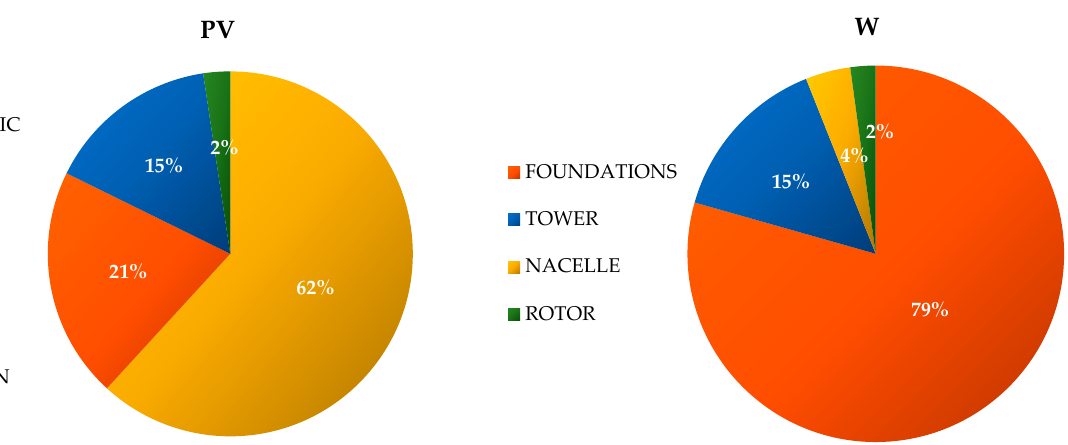
Figure 2. Percentage share of the most important materials from which the components of the wind and photovoltaic power plants were produced.